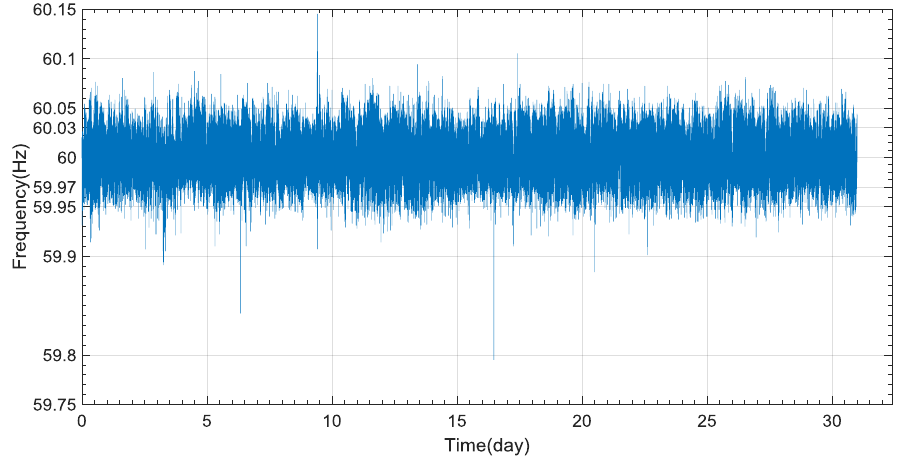
Figure 2. Measured frequency data in Korea’s power system.